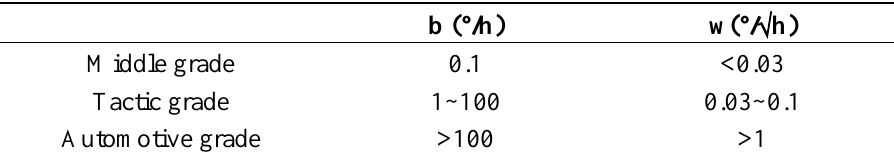
Table 2. “Current” accuracy levels of gyroscopes.